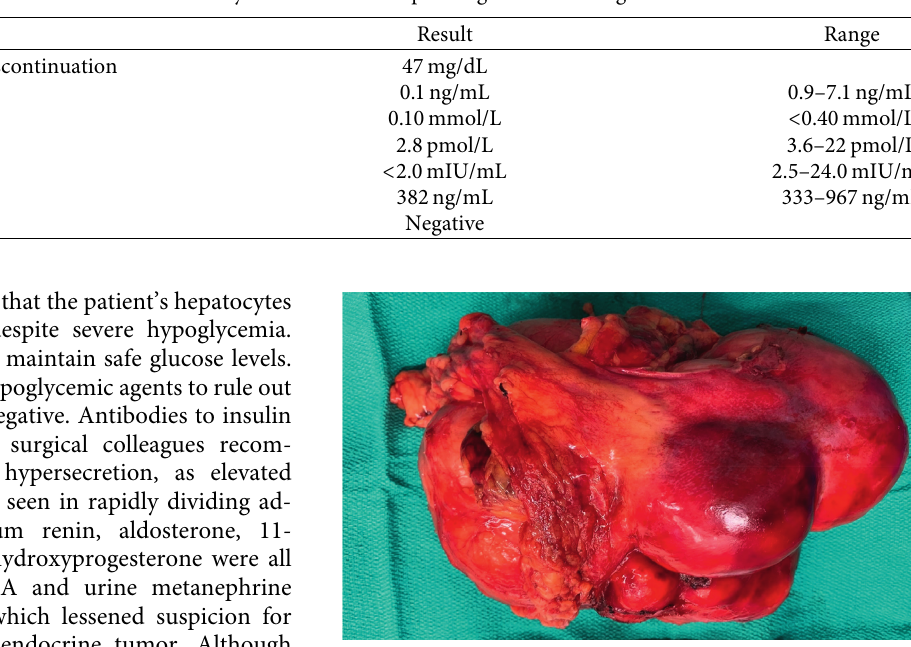
Figure 3: Gross image of solitary fibrous tumor. Specimen weighed 2270 grams with dimensions of 22.0cm × 18.0 cm × 12.0cm. Sol- itary fibrous tumors often appear as a well-circumscribed mass with tan-white homogeneous cut surfaces that can be cystic or